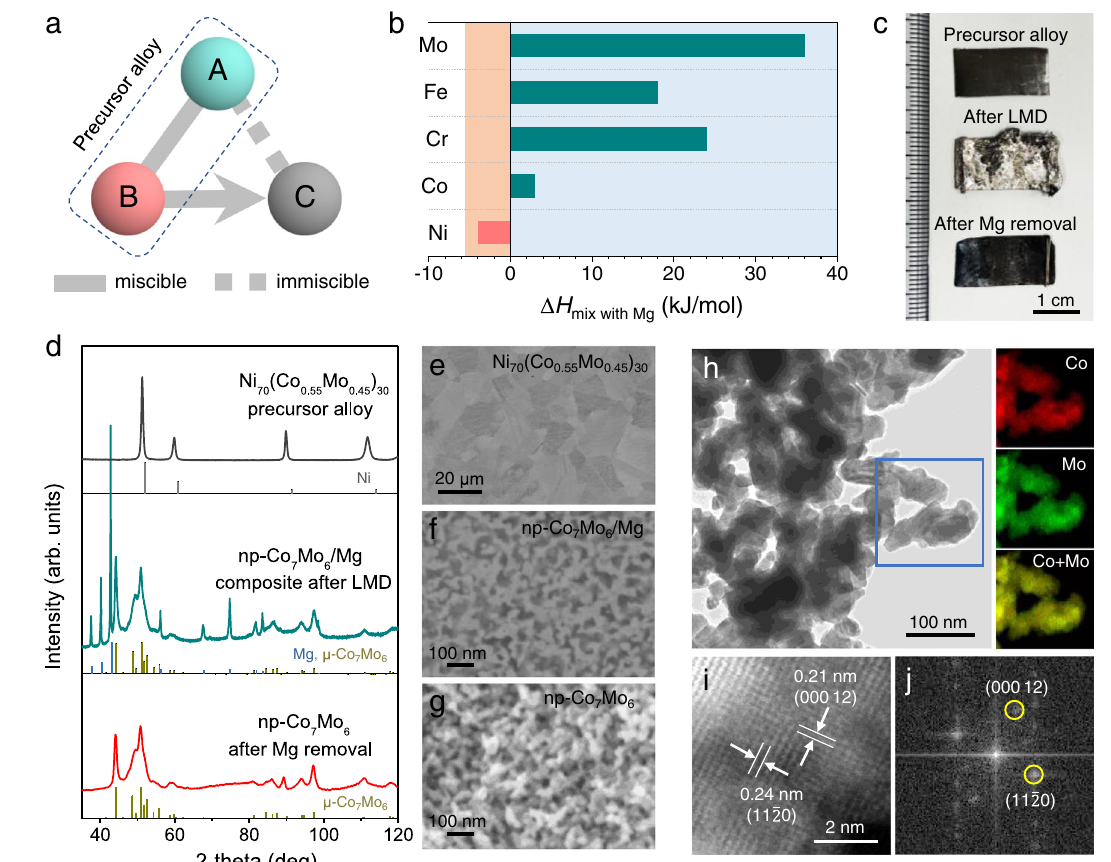
Fig. 1 | Design and fabrication of the nanoporous intermetallic compounds. a PrincipleofLMD. b Enthalpyofmixingbetweentheconsideredelementsandthe Mg melt. c Optical images, d XRDpatterns, and e – g cross-sectional SEM images of the ternary precursor alloy Ni 70 (Co 0.55 Mo 0.45 ) 30 , np-Co 7 Mo 6 /Mg composite obtained after LMD, and np-Co 7 Mo 6 obtained after further Mg removal. Standard